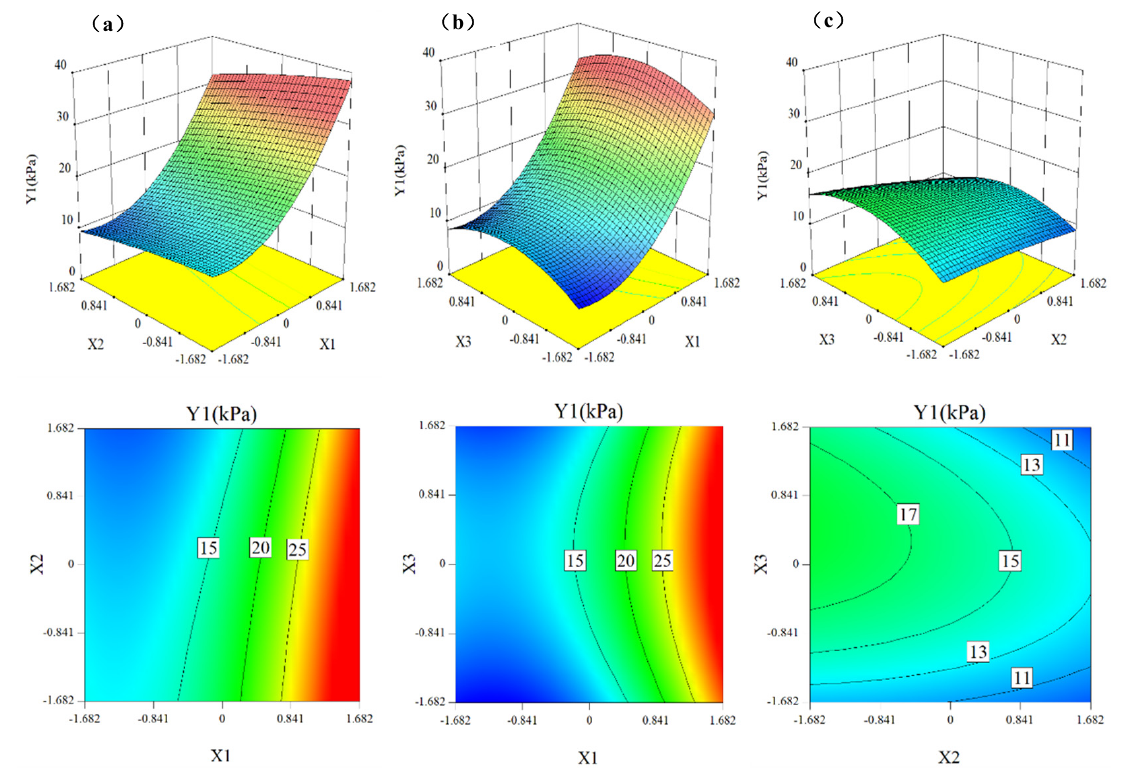
Figure 3. Interactive effects of ( a ) clay content and moisture content; ( b ) clay content and soil wet bulk density; ( c ) moisture content and soil wet bulk density on cohesion.